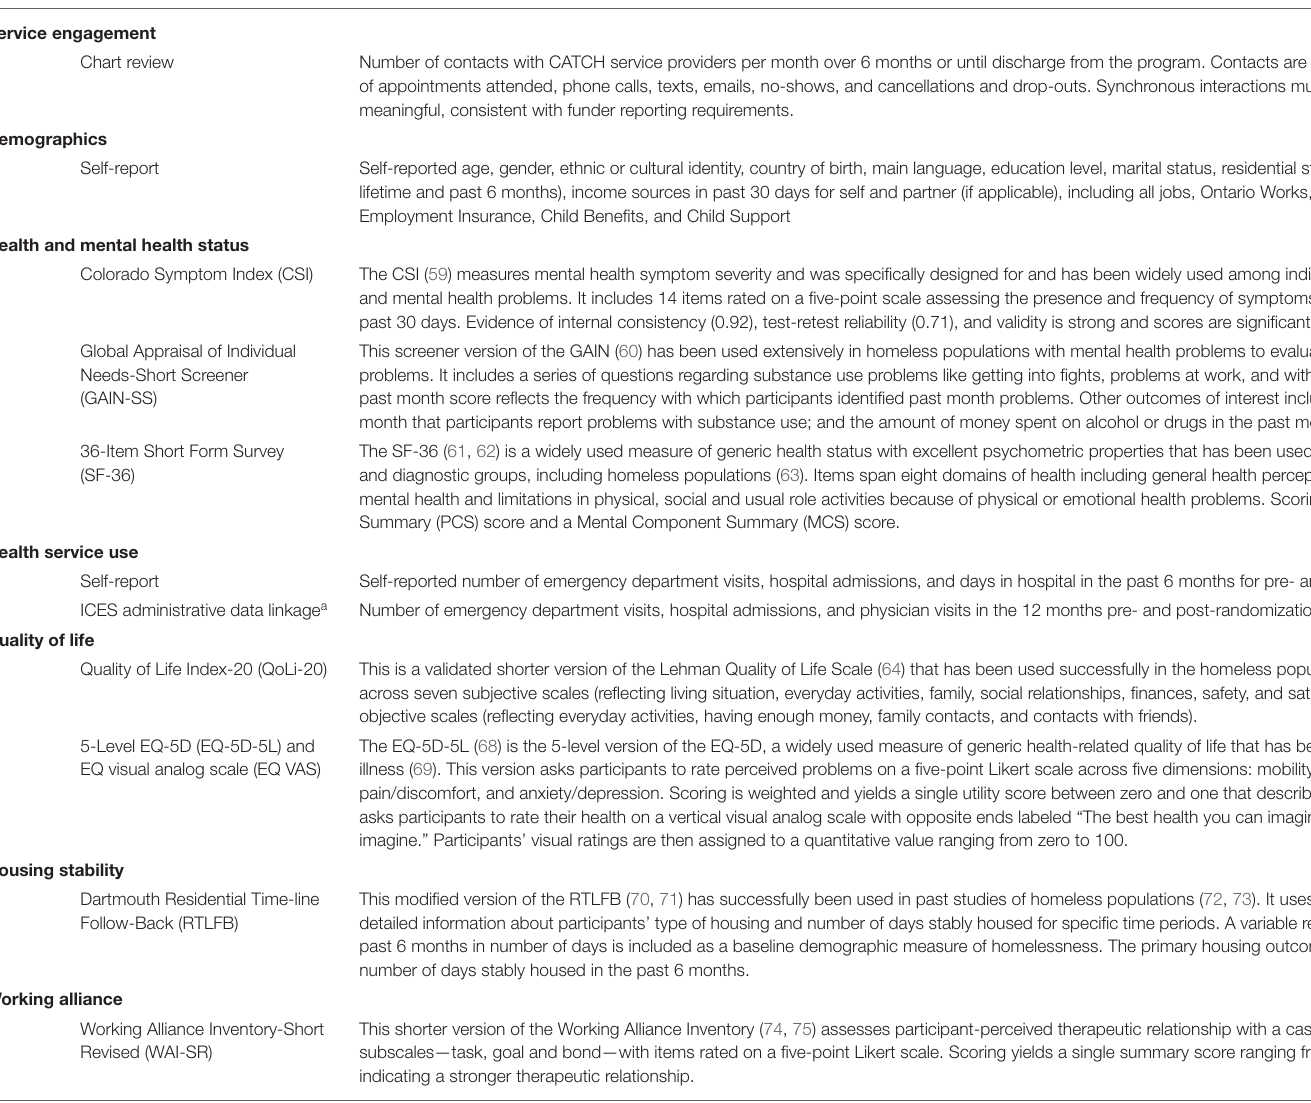
TABLE 1 | Description of